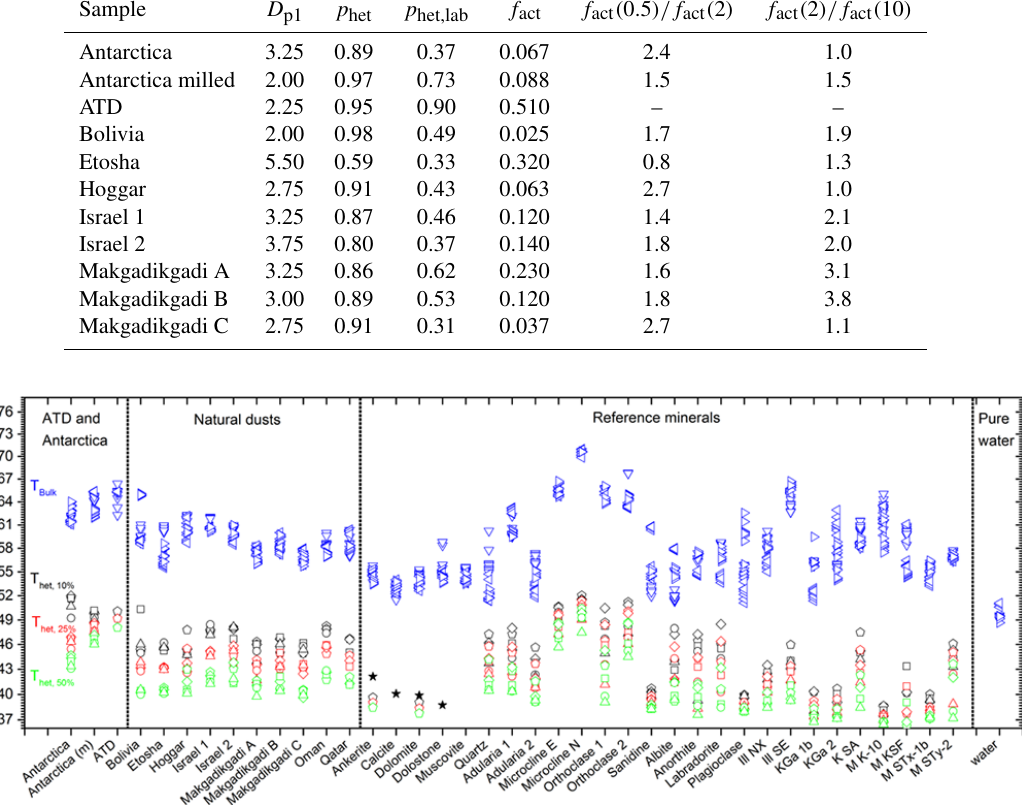
Figure 4. Overview of emulsion and bulk freezing temperatures of natural dusts and reference minerals determined from DSC experiments. Reference samples are from this study and from Pinti et al. (2012). Emulsion freezing experiments were carried out with suspension con- centrations of 0.5 wt% (triangles), 1wt% (circles), 2wt% (squares), 5wt% (diamonds), and 10wt% (pentagons). Temperatures of 10% heterogeneously frozen water volume ( T het , 10% ) , 25% heterogeneously frozen water volume ( T het , 25% ) , and 50% heterogeneously frozen water volume ( T het , 50% ) are given by black, red, and green symbols, respectively. Black stars give the onset temperatures for minerals with a weak heterogeneous freezing signal. Blue symbols refer to bulk measurements carried out with a 5wt% suspension. Different symbols refer to different bulk samples. On the far right, bulk measurements of pure water are shown for comparison, with freezing temperatures < 252.5K. Homogeneous freezing in emulsion samples occurs at T < 236 .